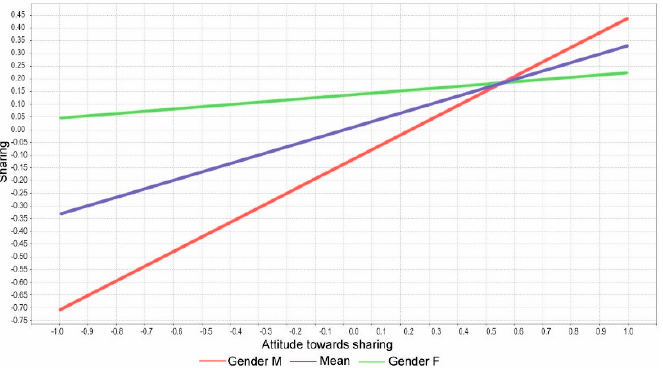
Figure 4. Simple slope analysis of moderating effect of variable “gender” on relation of “attitude towards sharing” and “sharing” constructs.